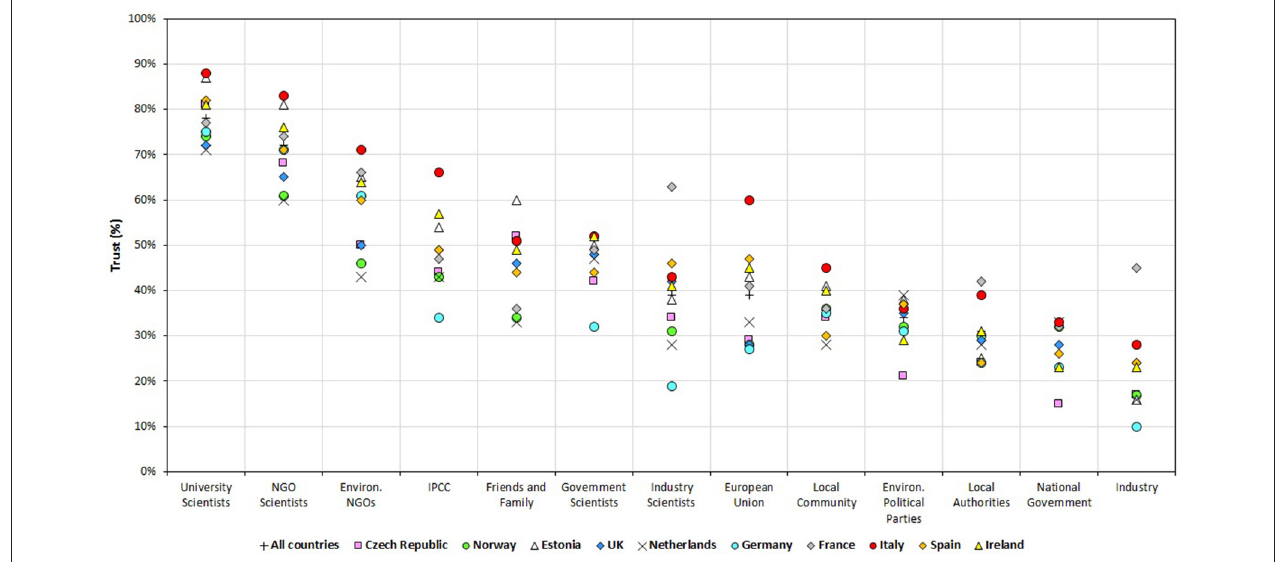
FIGURE 10 | Self-declared levels of “trust” in different organizations and types of government, among the 10 European countries surveyed. “Trust” = respondents answering 4 or 5 on a five-point scale, where 5 = trust a lot and 1 = distrust a lot. “Neither” = respondents answering the mid-point (3) on the same five-point scale.